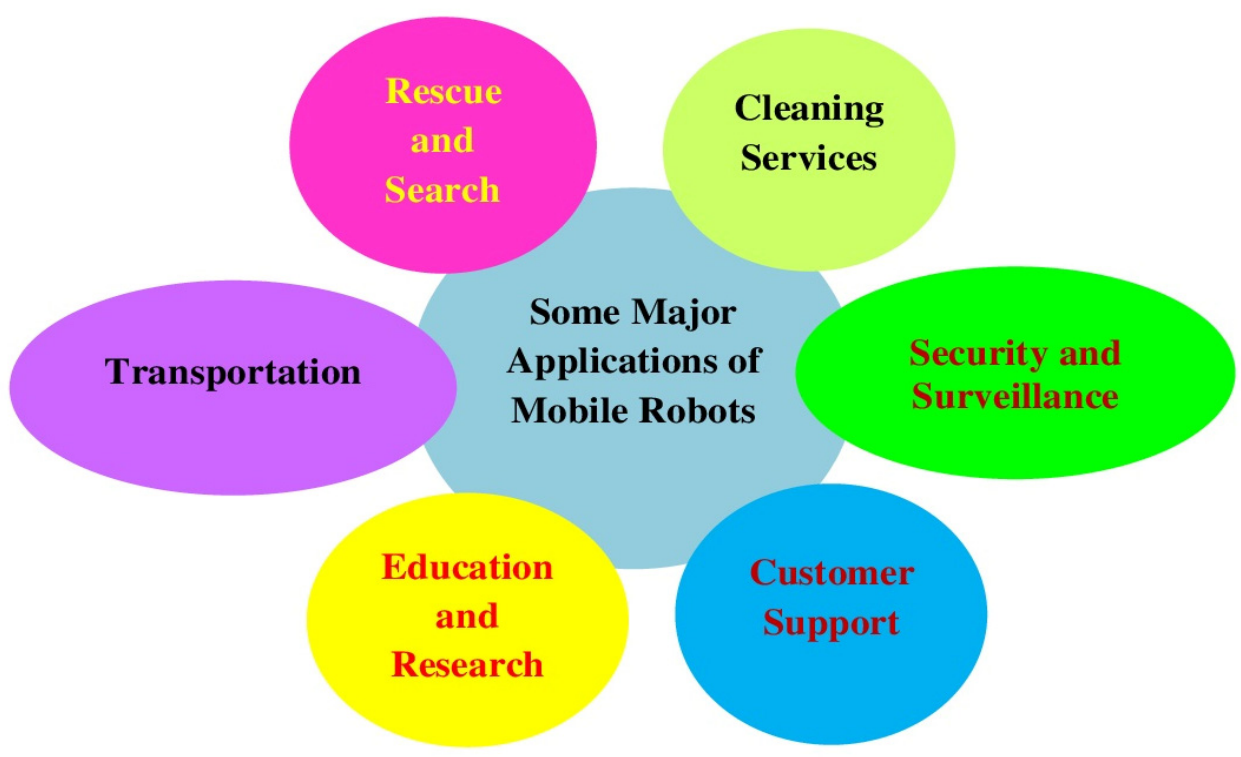
Figure 11. Some major applications of mobile